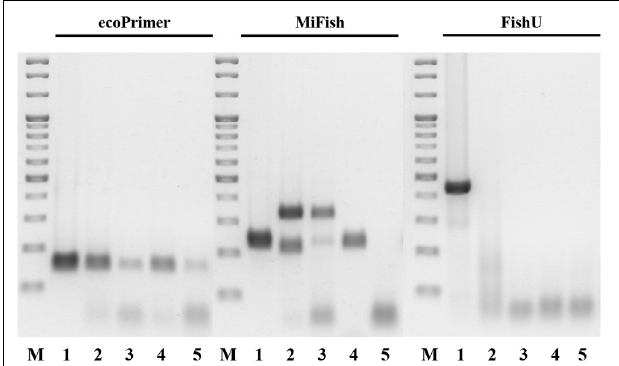
FIGURE 2 | Cross-reactivity of three primers. Merged image of three RT-PCR results by respective primer set. Lane M: 100 bp ladder molecular weight marker (Solgent, Korea). Lane 1: Engraulis japonicus (Positive control). Lane 2: Sagitta elegans . Lane 3: Euphausia pacifica . Lane 4: Metridia pacifica . Lane 5: Penaeus